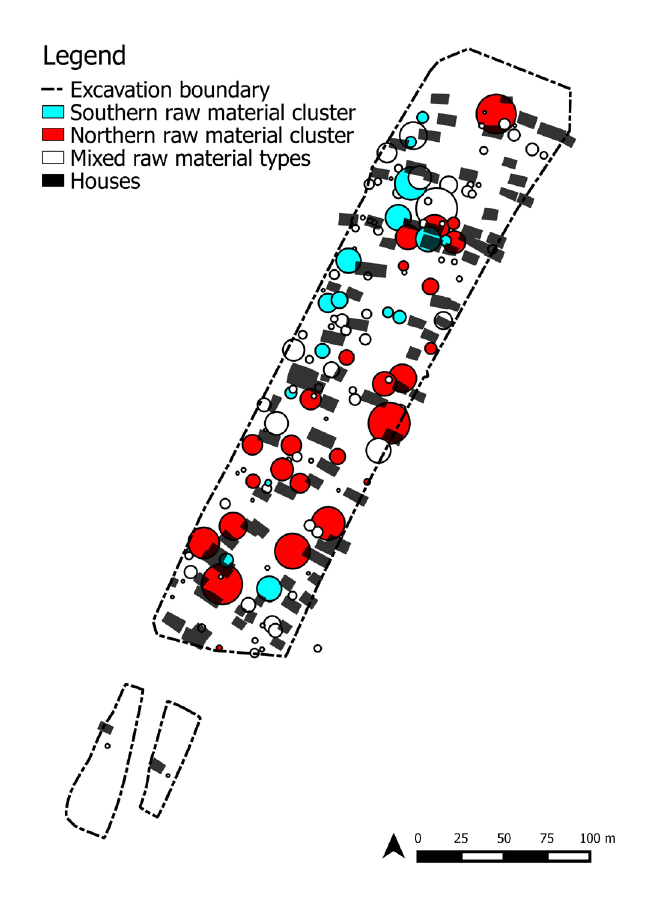
Figure 16: Spatial distribution of the raw material ratio